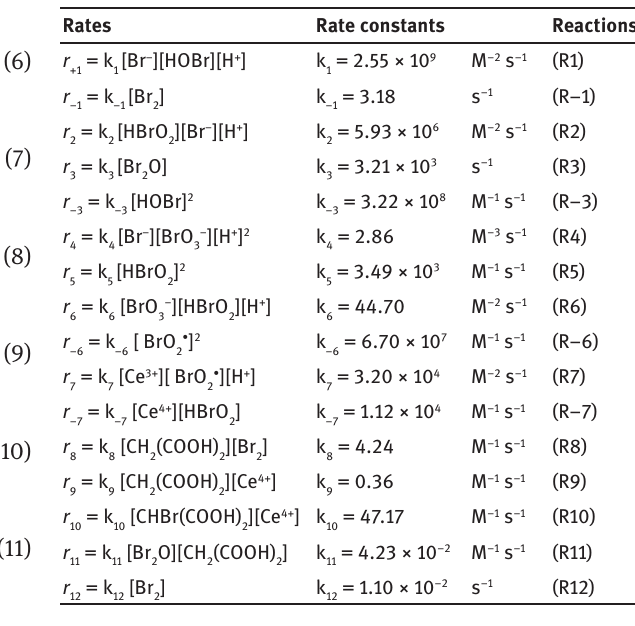
(COOH) ] values (in mol dm –3 ): 2 2 0 Table 2 : Rates and rate constants of the Model (Table 1) used in the numerical simulations of the Belousov−Zhabotinsky